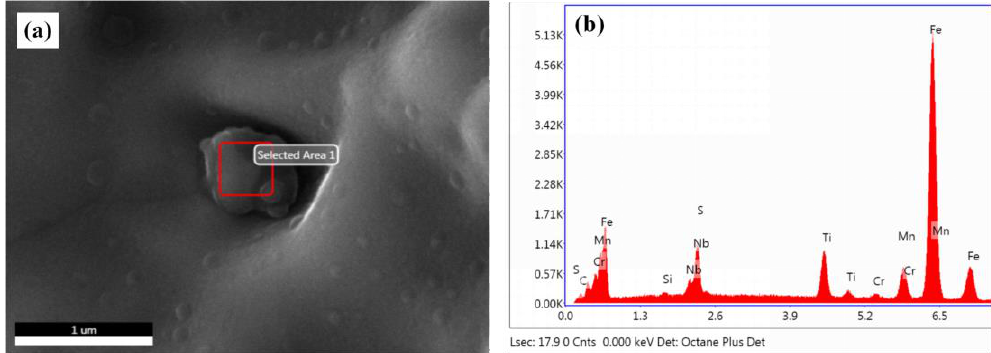
◦ C. ( a ) Scanning area; ( b ) energy spectrum. Figure 8. Fracture energy spectrum of Sb+Sn steel at 750 °C. ( a ) Scanning area; ( b ) energy spectrum. Figure 8. Fracture energy spectrum of Sb + Sn steel at 750 Metals 2020 , 10 , x FOR PEER REVIEW Figure 8. Fracture energy spectrum of Sb+Sn steel at 750 °C. ( a ) Scanning area; ( b ) energy spectrum.